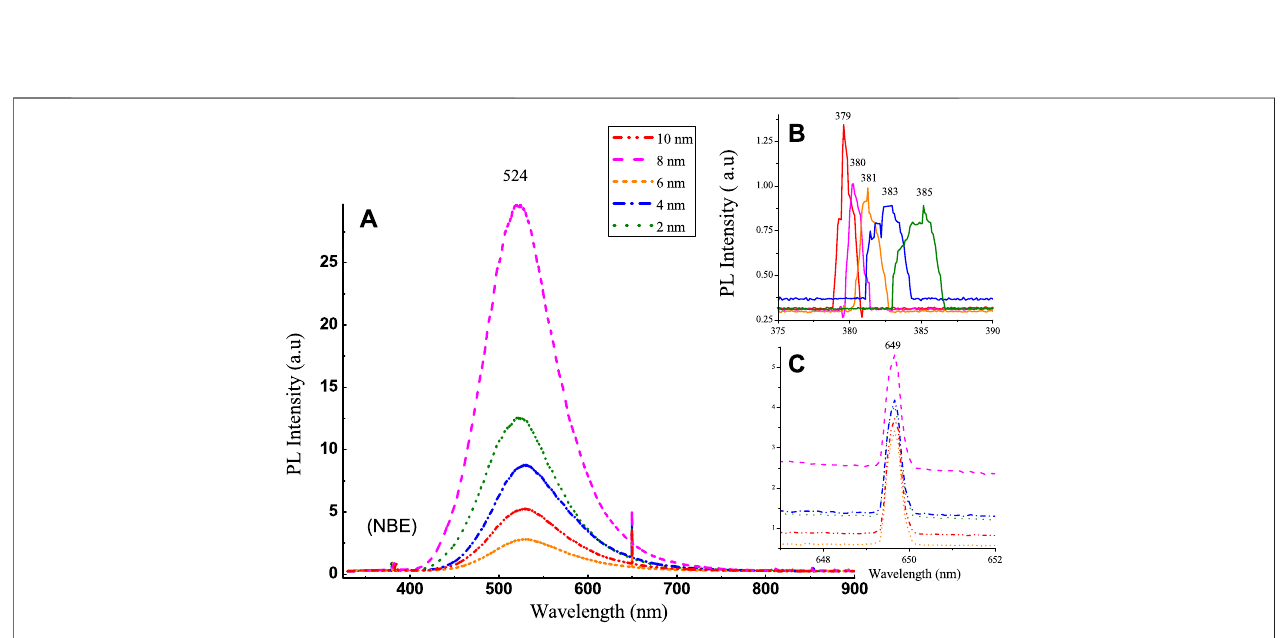
FIGURE13 |(A) PL spectrum ofthe annealed Aulayer ofvarious thicknesses on the Sisubstrate at room temperature (B) PL spectrum in the NBE region, and (C) shows Si peaks in the lateral region.